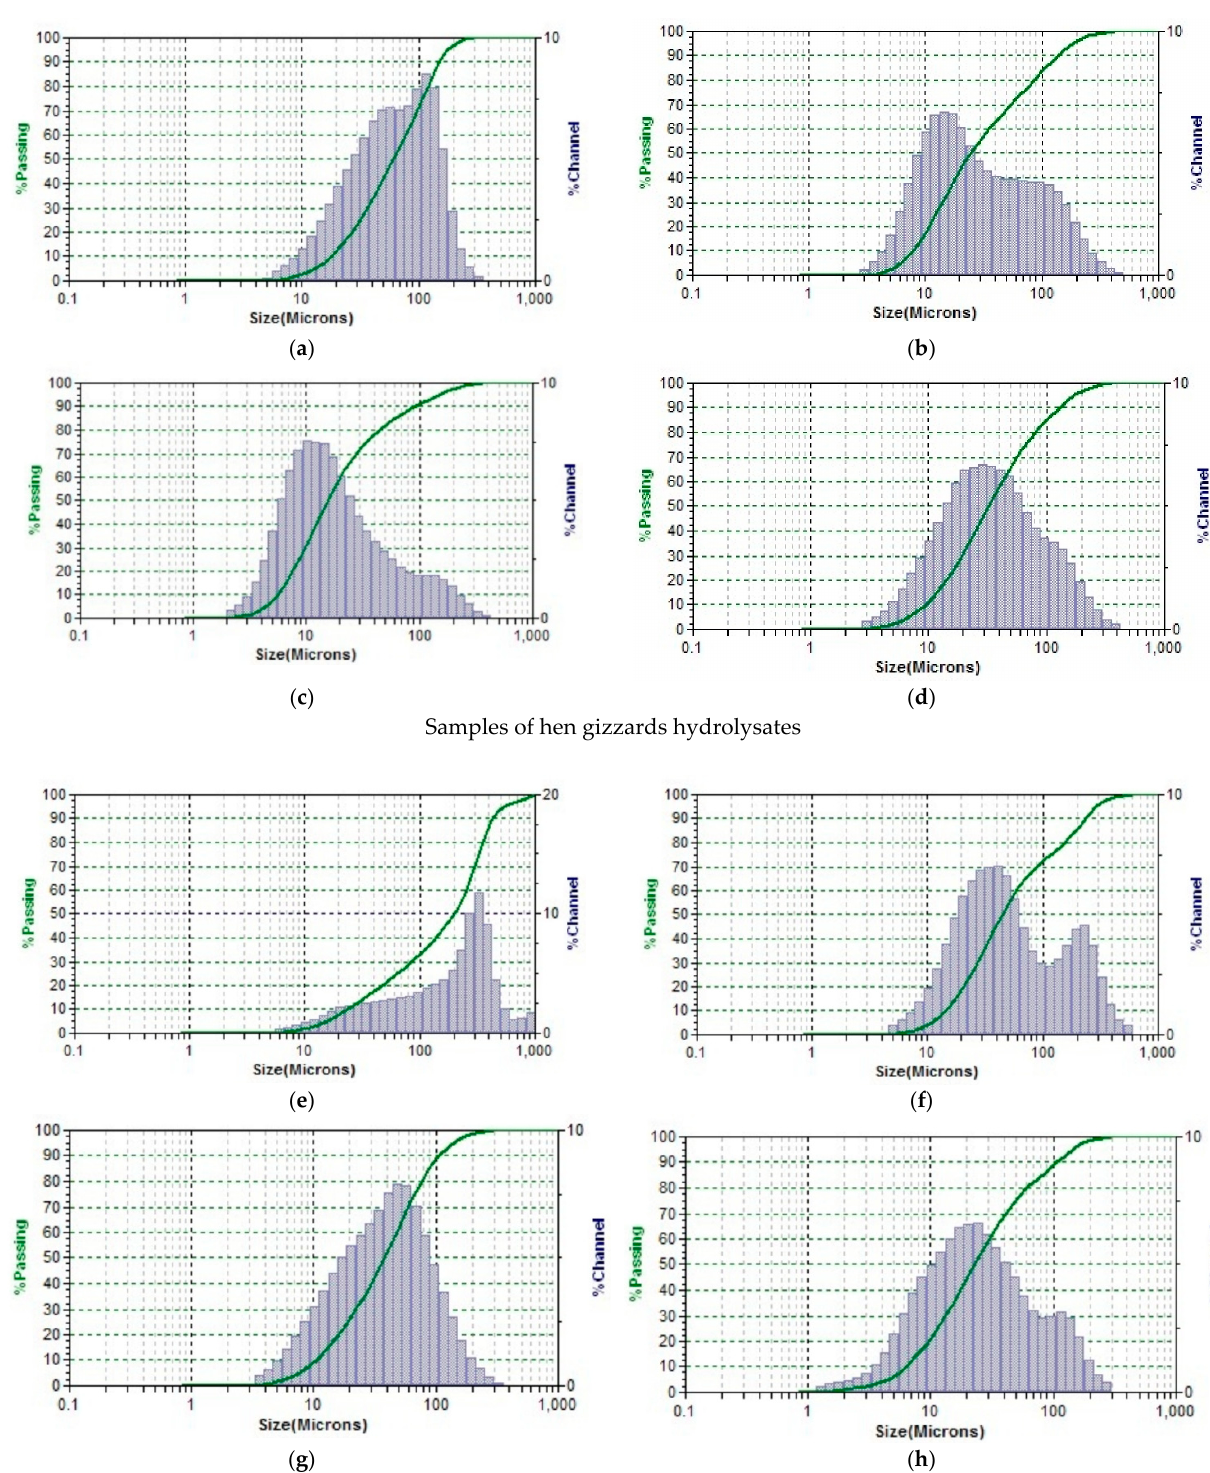
Figure 5. The results of the evaluation of the dispersed composition of gizzards hydrolysates—samples of hen gizzards hydrolysates: ( a ) control sample in the start time; ( b ) hydrolyzed control sample; ( c ) hydrolyzed test sample with Propionix LCSC; ( d ) hydrolyzed test sample with BLC; samples of broiler chicken gizzards hydrolysates: ( e ) control sample in the start time; ( f ) hydrolyzed control sample; ( g ) hydrolyzed test sample with Propionix LCSC; ( h ) hydrolyzed test sample with BLC.